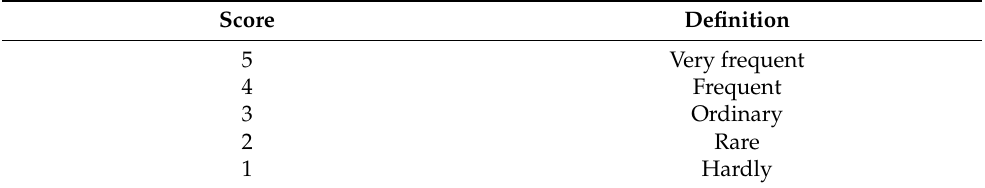
Table A2. Risk frequency scoring